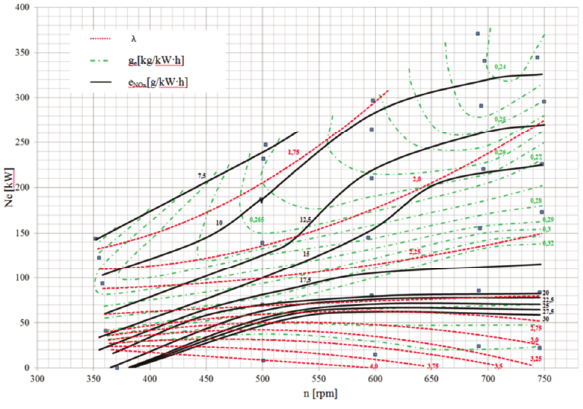
Fig. 3. Universal characteristics of the unit emission of